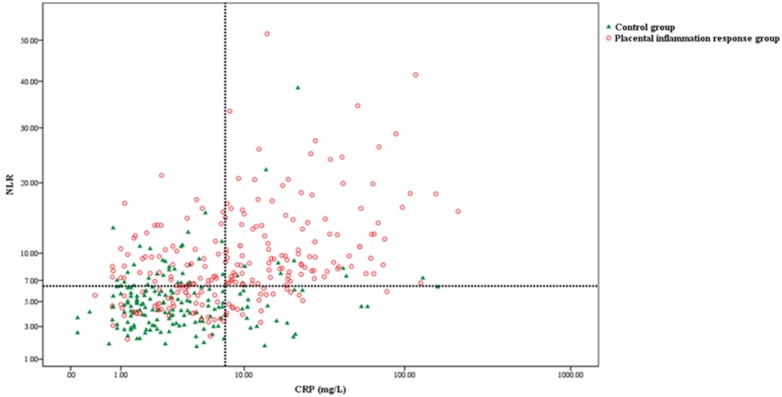
Comparison of neutrophil to lymphocyte ratio (NLR) (y-axis) and C-reactive protein (CRP) (x-axis) in placental inflammatory response group (red open circle) and control group (green filled triangle).The dotted lines indicate the optimal cut-off values (6.48) of NLR and CRP (7.46) which maximize the sum of sensitivity and specificity.